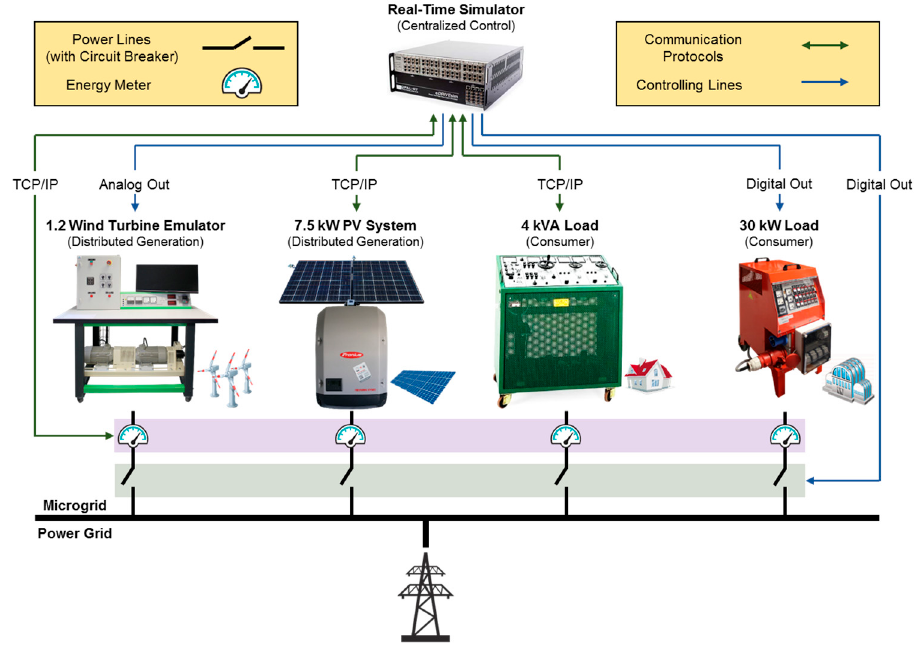
Figure 2. Centralized microgrid model architecture.